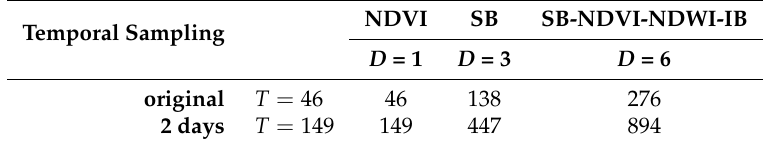
Table 2. Number of features ( D × T ) for the studied dataset with T the length of the time series, and D the number of spectral